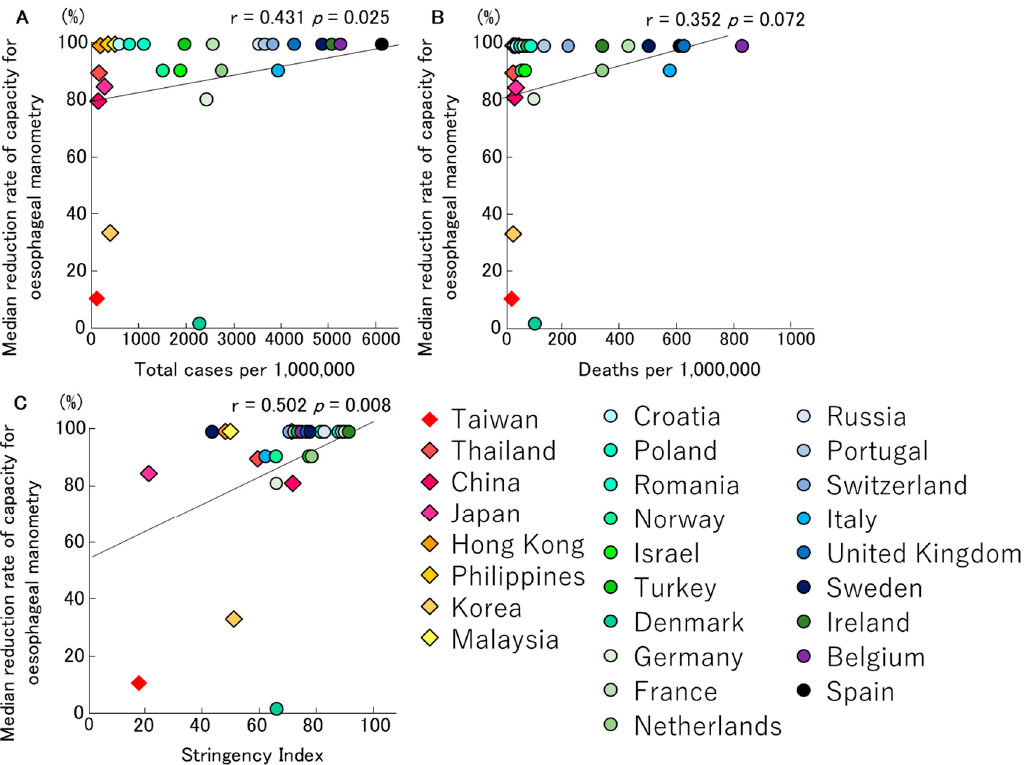
Figure 1. The relationships between median reduction rates of capacity for oesophageal manometry, total infection rate ( A ) / mortality rate ( B ) for COVID-19 and Stringency Index ( C ) in Asian and European countries, are described. There was a significant trend between the infection rates of COVID-19, the Stringency Index and the median reduction rates of oesophageal manometry.